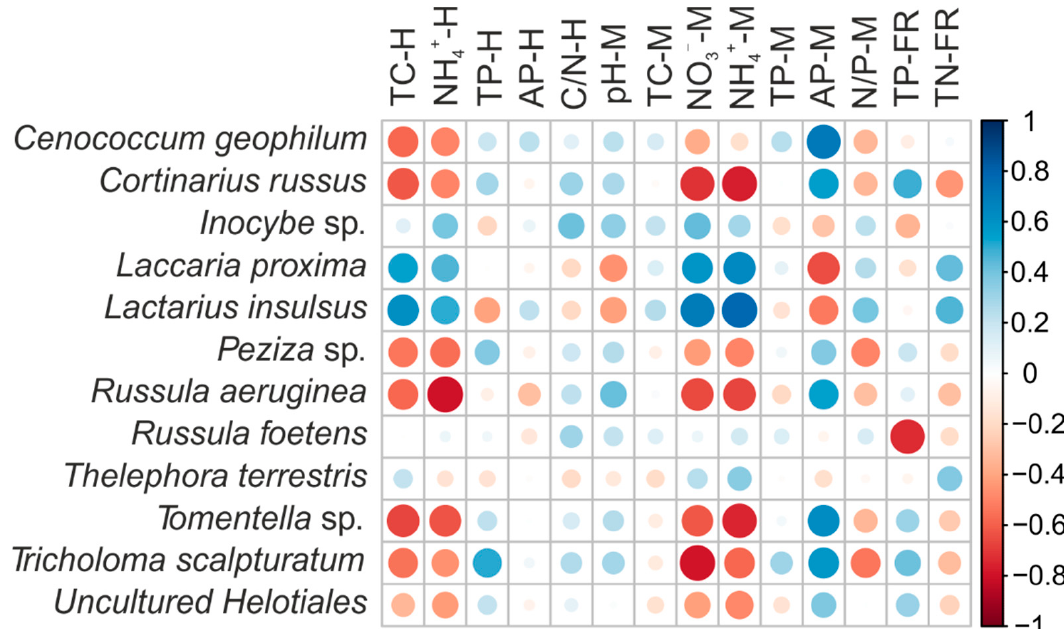
Figure 3. Pearson correlations between ectomycorrhizal fungi species and environmental factors in the poplar plantation under five N addition treatments. TC-H, TC in humus layer; NH 4+ -H, NH 4+ in humus layer; TP-H, TP in humus layer; AP-H, AP in humus layer; C/N-H, the ratio of TC to TN in humus layer; pH-M, pH in mineral soil; TC-M, TC in mineral soil; NO 3 − -M, NO 3 − in mineral soil; NH 4+ -M, NH 4+ in mineral soil; TP-M, TP in mineral soil; AP-M, AP in mineral soil; N/P-M, the ratio of TN to TP in mineral soil; TP-FR, TP in fine roots; and TN-FR, TN in fine roots. Values indicate means ± SE ( n =